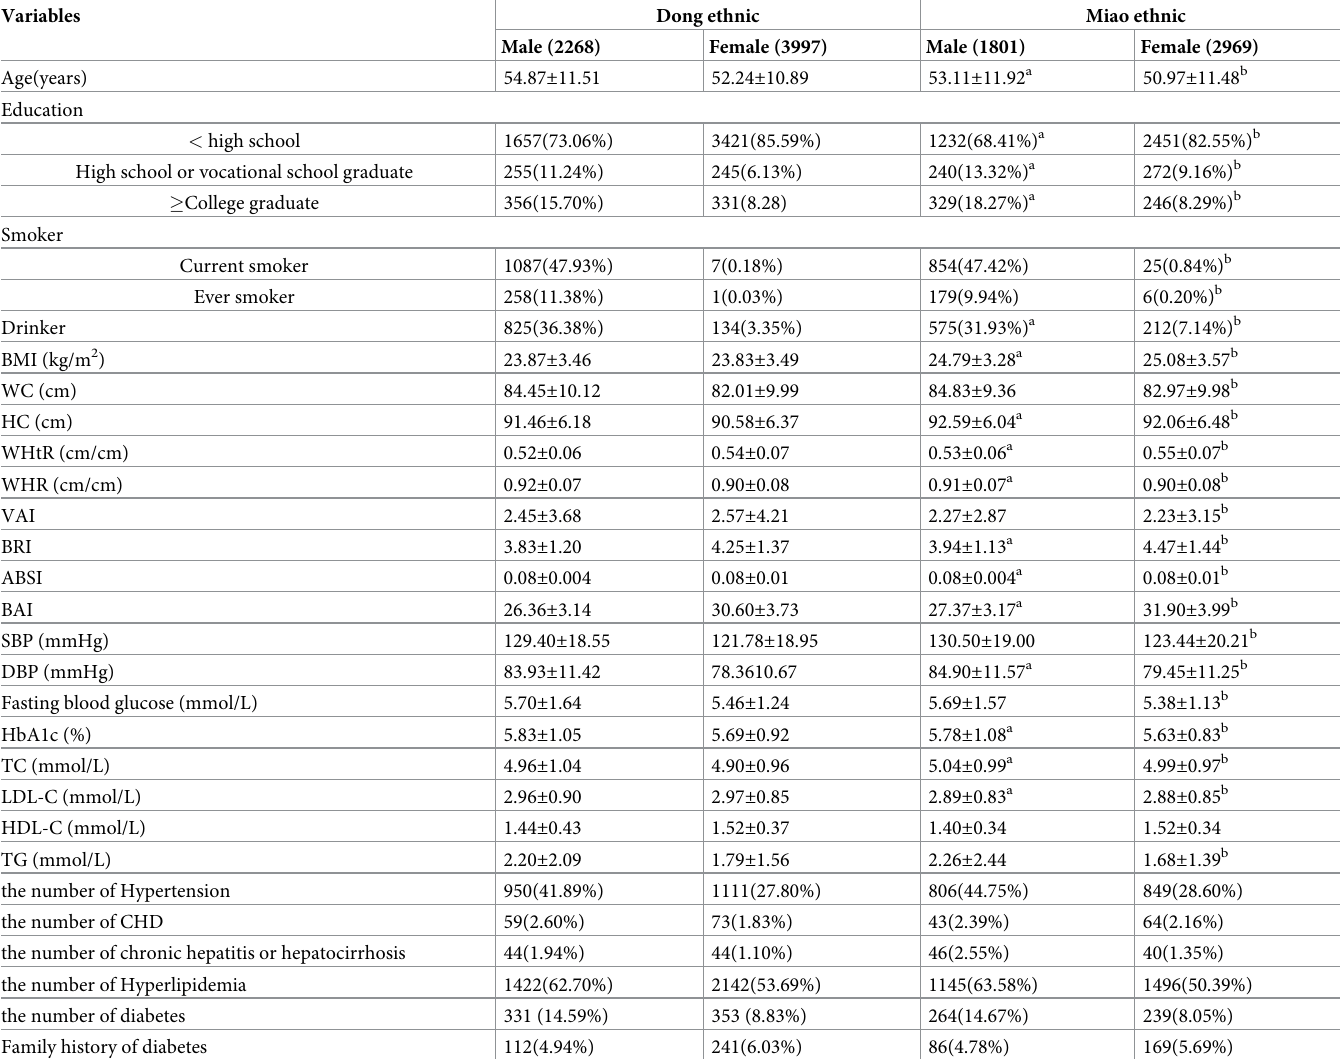
Table 1. Demographic characteristics of study